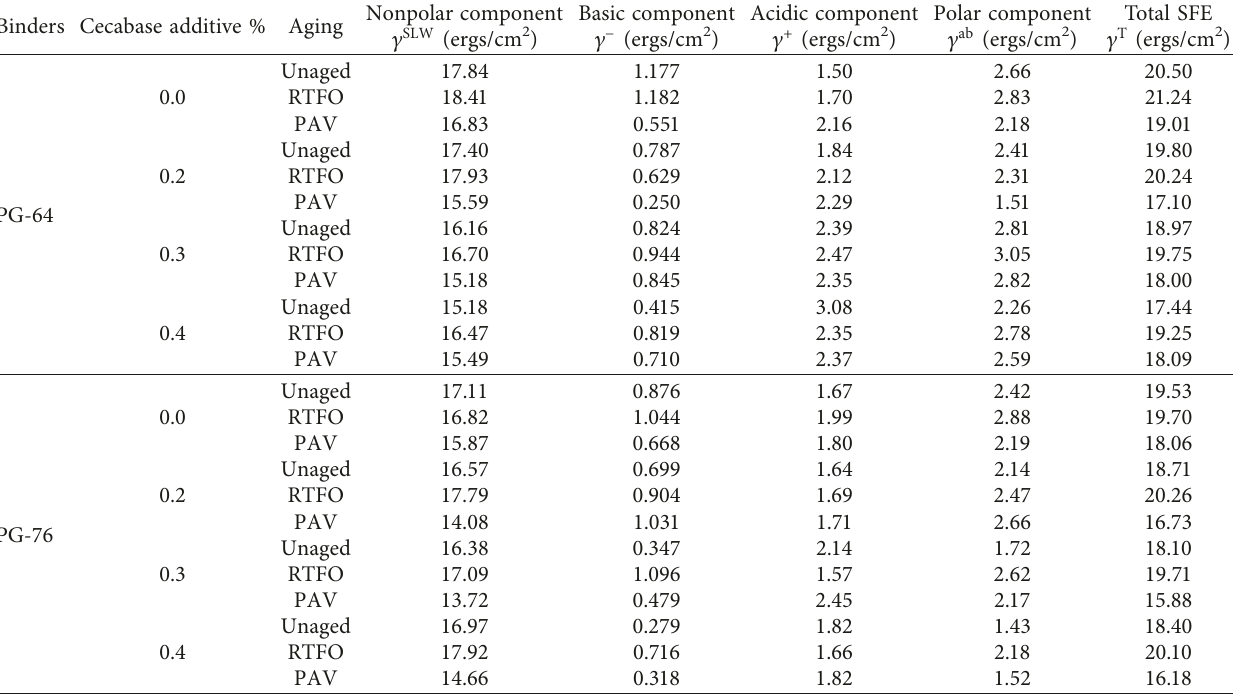
Table 7: SFE components of asphalt binders (advancing contact angle).